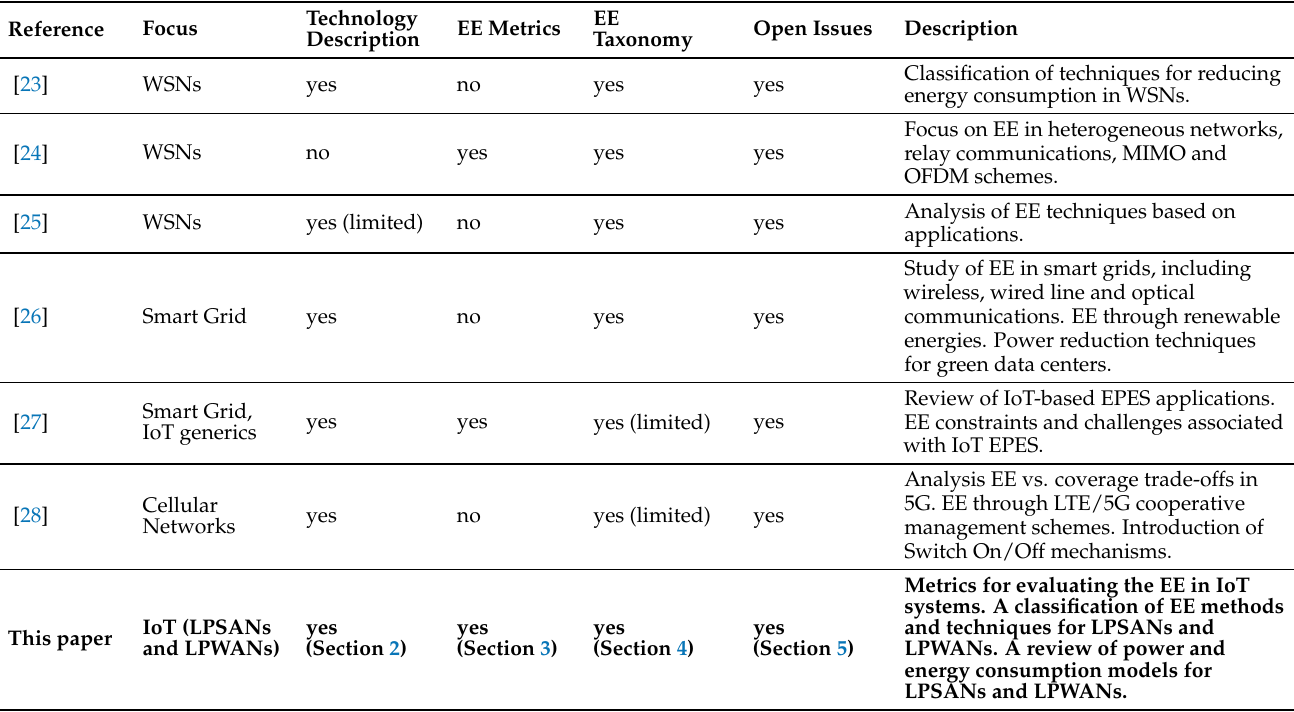
Table 1. A comparison of surveys on Energy Efficiency (EE) and consumption in communication systems.